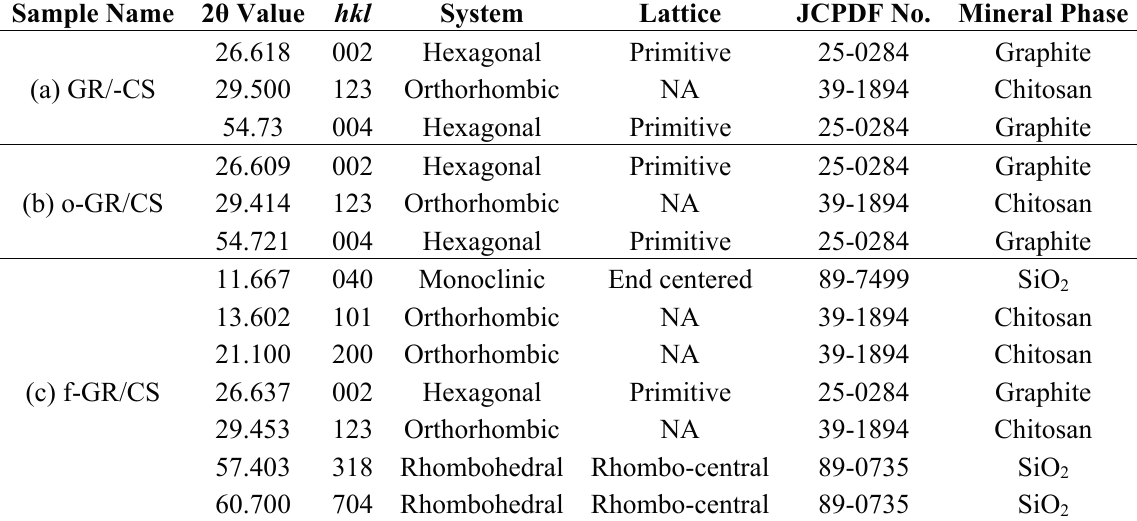
Figure 5. XRD patterns of GR/CS, o-GR/CS and f-GR/CS composite films. PDS #C represents the ICDD Powder Diffraction Standards (PDS) card numbers in the form of Powder Diffraction File (PDF) for the presence of carbon. Table 3. XRD details of sample peaks as indexed in ICDD JCPDF